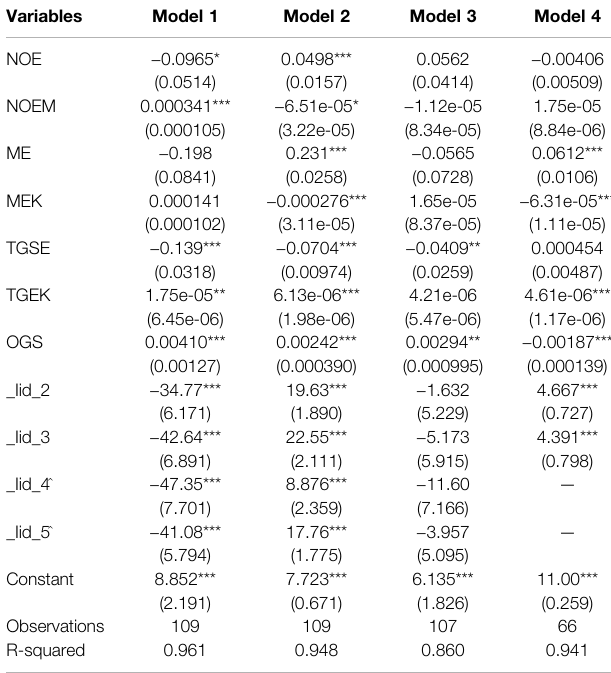
TABLE 3 | Climate extreme and agriculture dynamics under LSDV